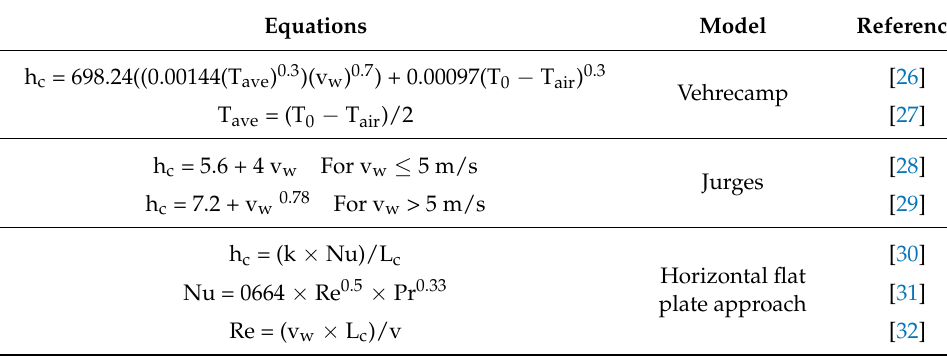
Table 1. Empirical equations to determine the pavements temperature profiles’